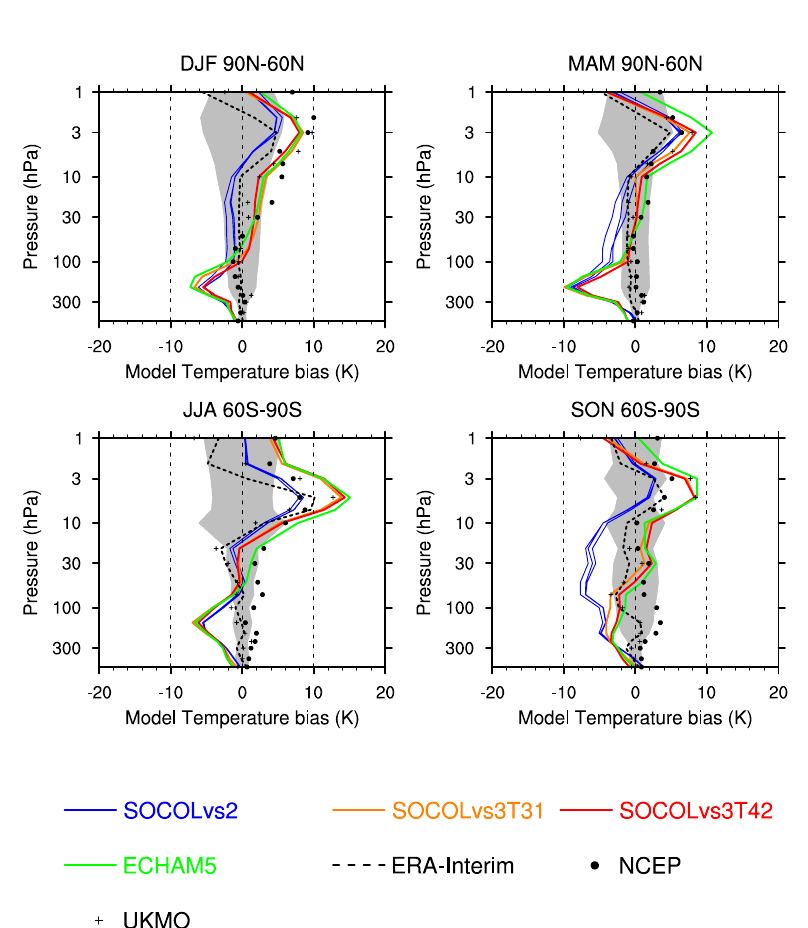
Fig. 2. Climatological mean (1980–1999) temperature biases relative to the ERA-40 reanalysis for 60–90 ◦ N (top) and 60–90 ◦ S (bottom) during winter (left) and spring (right). Biases are calculated for SOCOLvs2 (blue lines, 3 ensemble members), SOCOLvs3 T31 horizontal resolution (orange line), SOCOLvs3 T42 horizontal resolution (red line), MA-ECHAM5 T31 horizontal resolution (green line) and for ERA-Interim (dashed black line, 1989–1999), NCEP (dots, 1980–1999) and UKMO (crosses, 1992–2001) reanalyses. The grey area shows ERA-40 plus and minus 1 standard deviation about the climatological